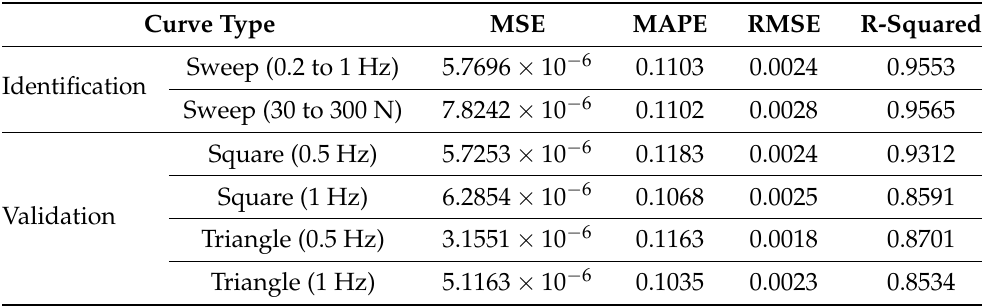
Table 2. Model accuracy of the identification and validation (MSE:mean squared error; MAPE: mean absolute percentage error; RMSE: root-mean-square